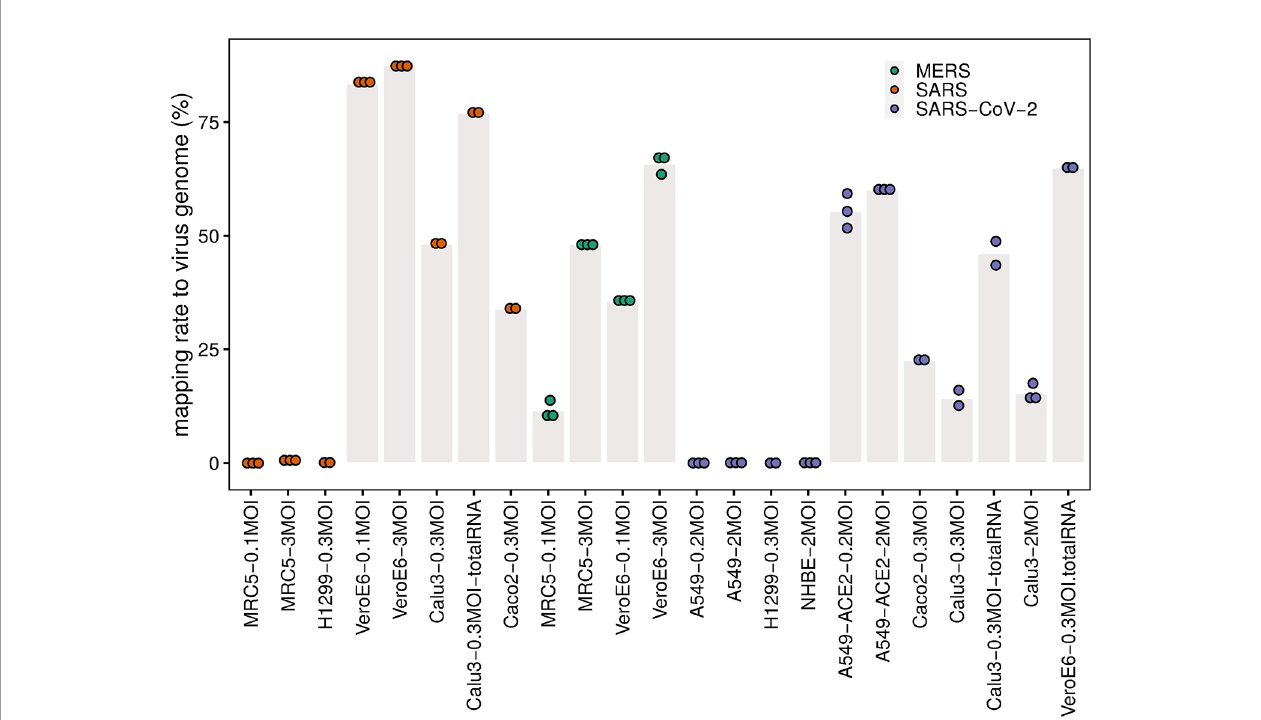
FIGURE 1 | Mapping rate to virus genome. The dots represent the mapping rates to the virus genome for each individual replicate under the given conditions (cell line, MOI, and virus). Bar heights are mean mapping rates to the virus genome for each